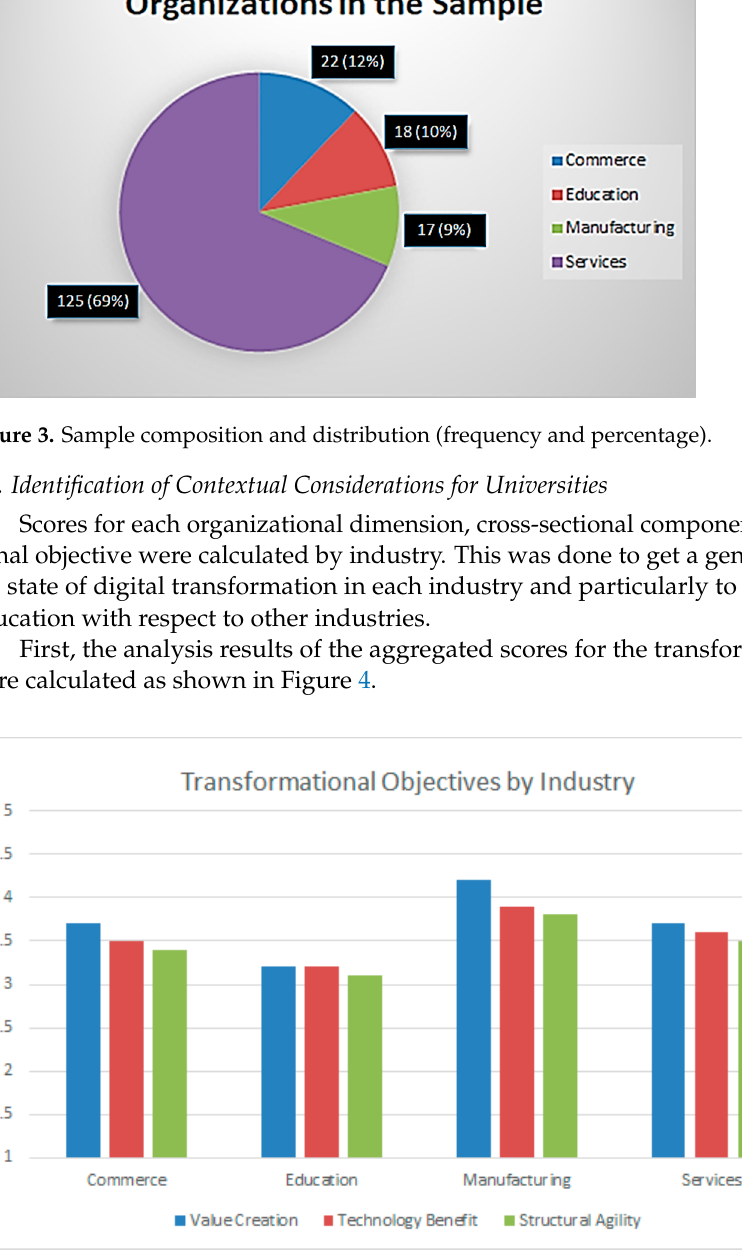
Figure 4. Transformational objective analysis.